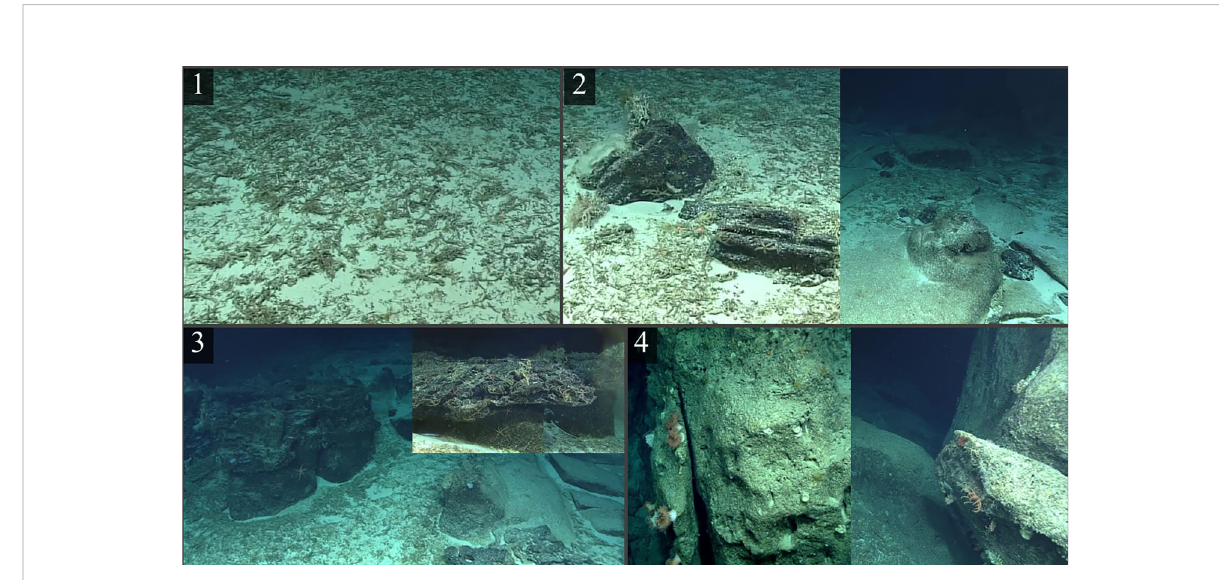
FIGURE 2 Qualitative classi fi cations of substrate rugosity used to assess the relationship between habitat and biodiversity in deep-sea communities (1 – 4, EX1705 Dive 05, Jarvis Island). Rock feature height and abundance were used to classify rugosity. Two examples of each rugosity classi fi cation are shown for levels 2 – 4. Photo credit: NOAA Ocean